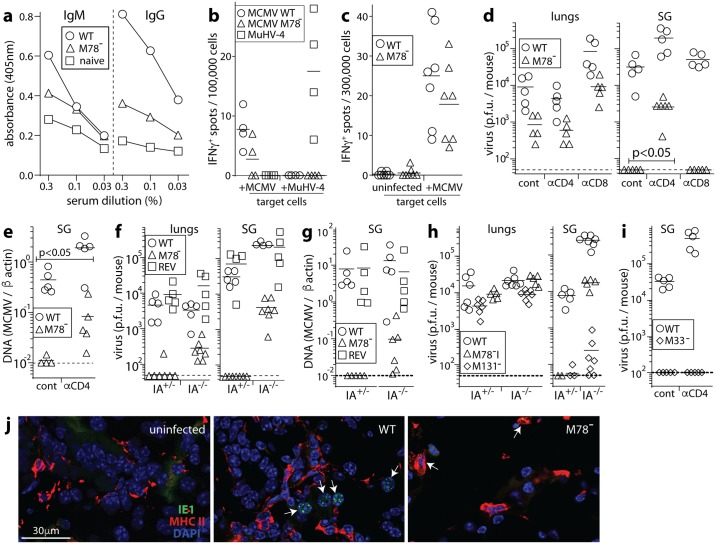
Significant M78- MCMV rescue by CD4+ T cell loss.a. C57BL/6 mice were given WT or M78- MCMV i.n. (3x104 p.f.u.). 56d later sera were assayed for MCMV-specific IgG and IgM by ELISA. Naive = age-matched, uninfected controls. Each point shows the mean of results for 7 mice. M78- MCMV elicited significantly less IgG response than WT (p<0.01). b. C57BL/6 mice were given WT or M78- MCMV, or as a control MuHV-4 i.n. (3x104 p.f.u.). 56d after MCMV infection or 10d after MuHV-4 infection, CD4+ T cells were purified from splenocytes, pooled from 2 mice per group, by depleting other cells with magnetic beads (Untouched mouse CD4 cell kit, Thermofisher). IFNγ production in response to MCMV-exposed or MuHV-4-exposed naive syngeneic spleen cells (1 p.f.u. / cell) was measured by ELIspot assay. Symbols show replicate wells, bars show means. c. C57BL/6 mice were given WT or M78- MCMV i.n. (3x104 p.f.u.). 56d later IFNγ production by splenocytes exposed to uninfected or MCMV-exposed naive syngeneic spleen cells was measured by ELIspot assay. Symbols show individual mice, bars show means. CD4+ T cell responses to WT and M78- MCMV were not significantly different. d. BALB/c mice were depleted of CD4+ or CD8+ T cells (αCD4, αCD8) or left undepleted (cont), then given i.n. WT or M78- MCMV (3x104 p.f.u.). 10d later lungs and SG were plaque assayed for infectious virus. Symbols show individuals, bars show means. In lungs, immune depletions did not significantly change the ratio of WT to M78- titers. In SG, CD4+ T cell depletion significantly reduced this ratio. e. Viral DNA loads of SG in d were determined by QPCR. Again CD4+ T cell depletion significantly reduced the ratio of WT to M78- infection, that is significantly reversed the M78- infection defect. f. Immunocompetent (IA+/-) and MHC II- (IA-/-) C57BL/6 mice were given WT, M78- or revertant (REV) MCMV i.n. (3x104 p.f.u.). At d10 lungs and SG were plaque-assayed for infectious virus. Symbols show individual mice, bars show means. For both lungs (p<0.05) and SG (p<0.01), CD4+ T cell loss (IA-/- mice) significantly increased M78- plaque titers relative to WT or REV. g. For the mice in f, CD4+ T cell loss significantly increased M78- viral DNA loads in SG relative to WT or REV (p<0.05). h. IA-/- and IA+/- mice were given i.n. WT, M131- or M78 deletion mutant (M78-I) MCMV. At d10 lungs and SG were plaque assayed for infectious virus. Symbols show individuals, bars show means. The ratio of M78-I/WT salivary gland titers was significantly higher in IA-/- than IA+/- mice (p<0.01), while the ratio of M131-/WT salivary gland titers was reduced. i. BALB/c mice were depleted of CD4+ T cells as in d, then given WT or M33- MCMV i.n.. After 10d SG were plaque assayed for infectious virus. Symbols show individuals, bars show means. CD4+ T cell depletion increased WT MCMV SG infection but failed to rescue SG infection by M33- MCMV. j. BALB/c mice were depleted of CD4+ T cells and given WT or M78- MCMV i.n. as in d. At d10 salivary gland sections were stained for MHC II and MCMV IE1. UI = uninfected control. Arrows show example infected cells (speckled nuclear IE1 staining). These cells were all MHC II- with WT MCMV and MHC II+ with M78- MCMV. Images are representative of 6 mice per group.